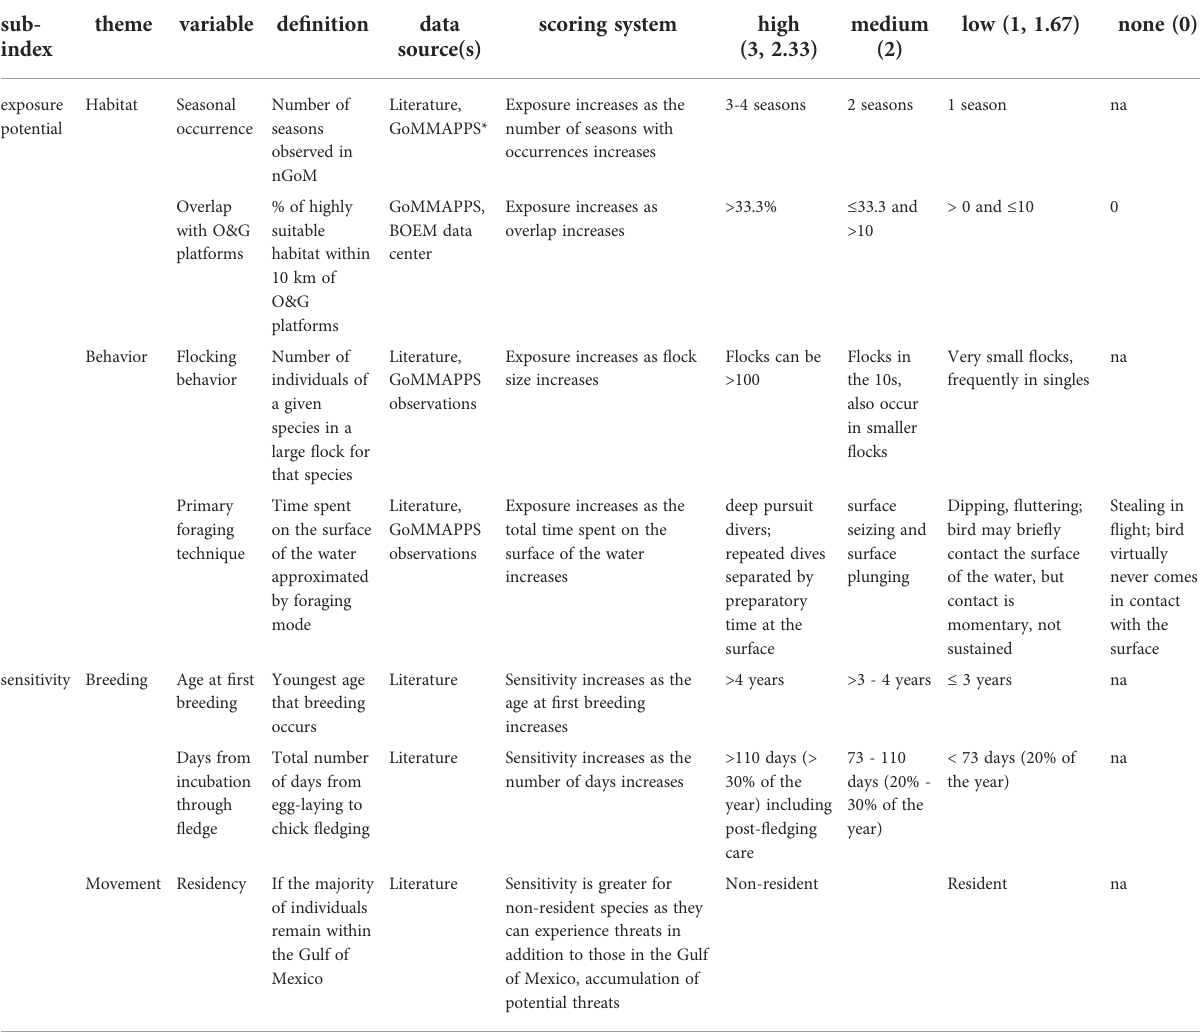
TABLE 1 Brief descriptions of each variable used to develop the oil vulnerability index for seabirds and rules for assigning scores indicating the potential impact of oil for each variable and